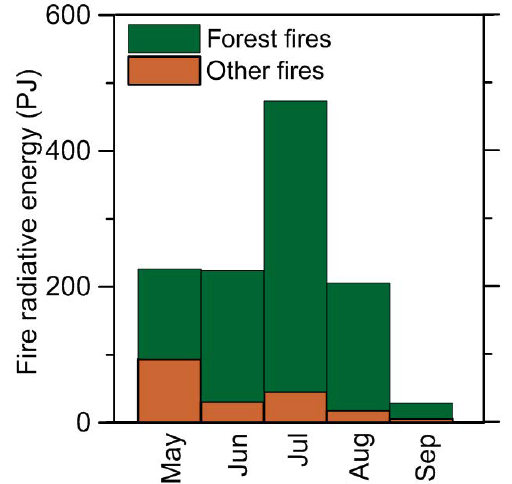
Figure 3. Estimates of the total fire radiative energy (in PJ) released from forest and other vegetation fires in the study region (see Fig. 2) in the period from May to September 2012. The estimates in this study were obtained from the MODIS FRP measurements as ex- plained in Sect.